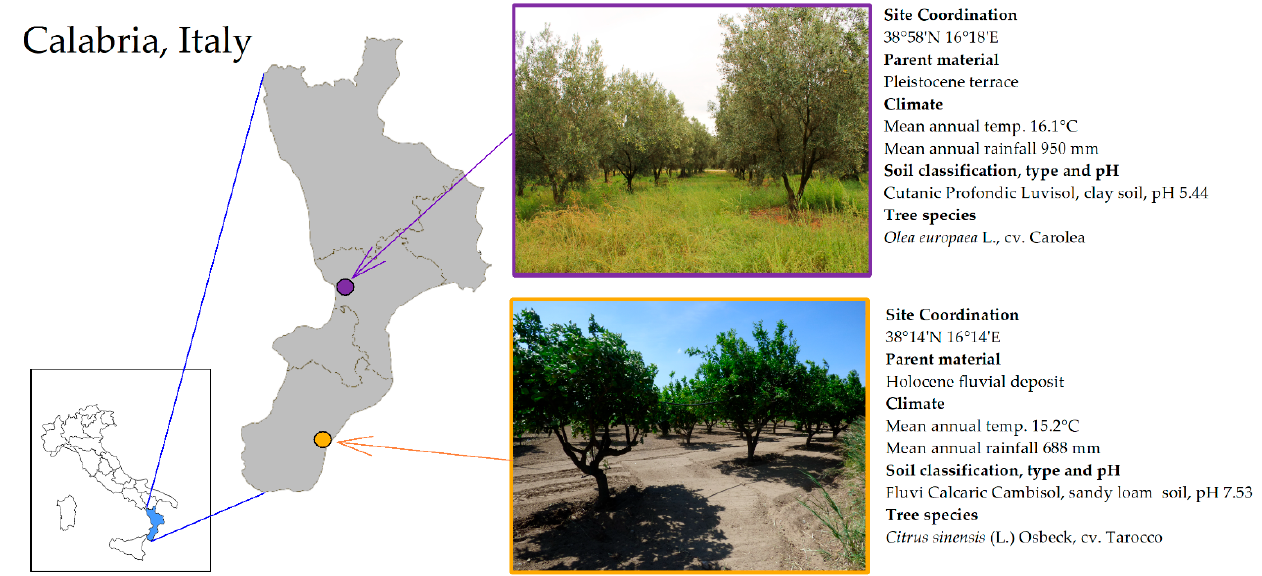
Figure 1. Overview of the two experimental sites: Lamezia Terme (olive orchard) and Locri (orange orchard). Inset text includes mean annual temperature and rainfall, crop species, site coordination, and major soil information.